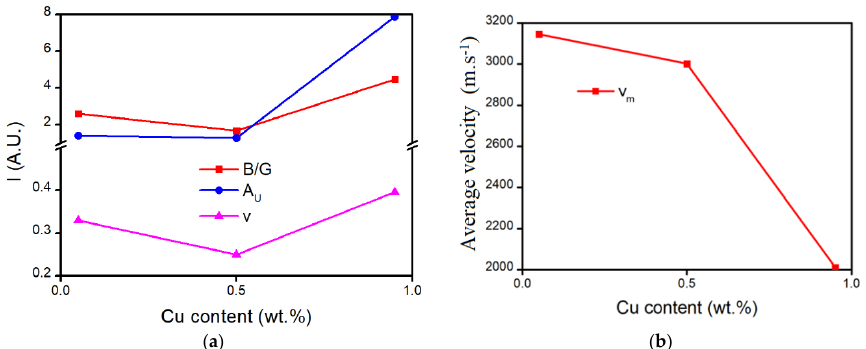
Figure 4. Cu content ‐ dependent brittleness and stiffness: ( a ) criterion for ductile and brittle B / G , anisotropic index A U , and Poisson’s ratio v ; ( b ) average velocity v m .